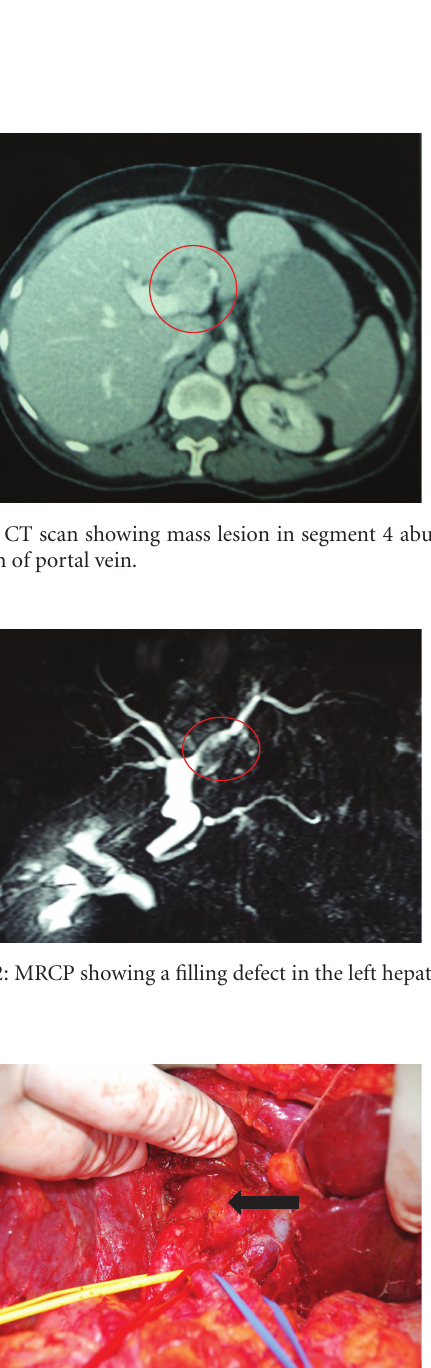
Figure 5: Immunohistochemistry staining positive for Chromo- granin (a) and Synaptophysin